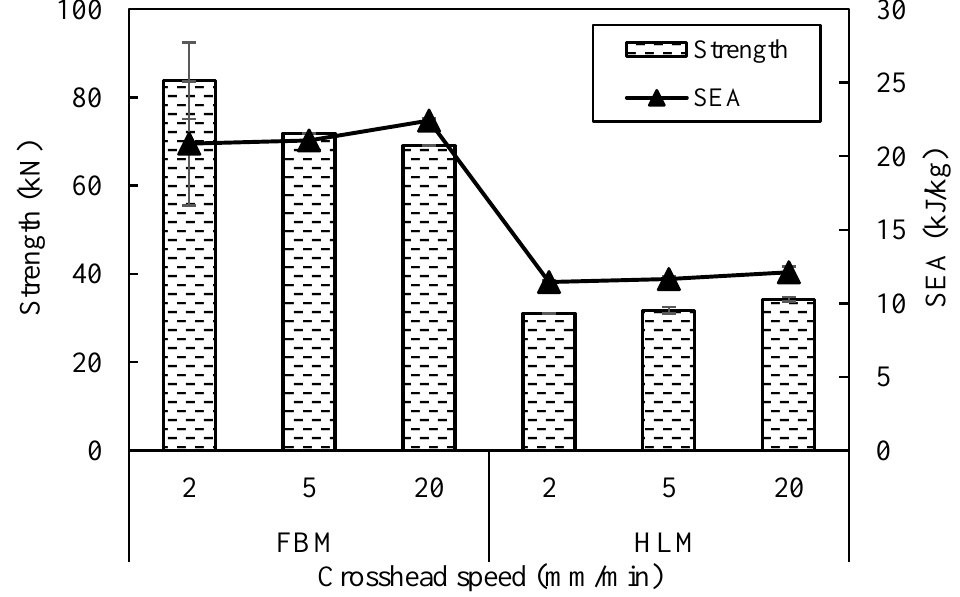
Figure 14. Compressive strength and SEA for FBM and HLM structure with three different compression crosshead speed.